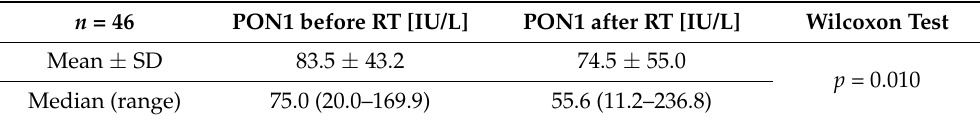
Table 2. Serum paraoxonase-1 (PON1) activity in prostate cancer patients before and after radiother- apy